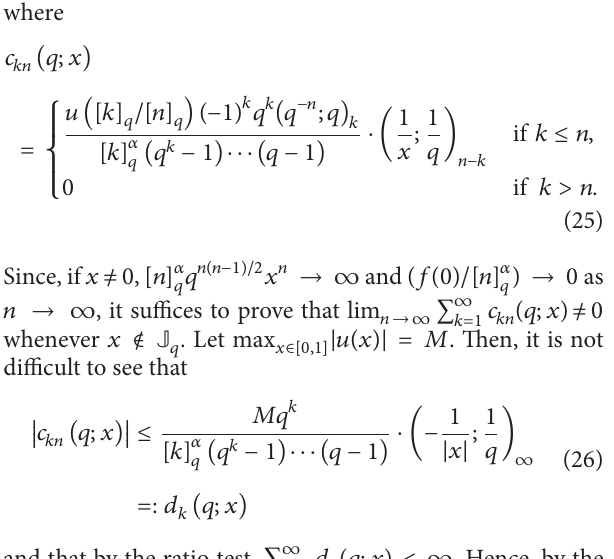
Figure 1: Graphs of 𝑦 = 𝑔(𝑥) and 𝑦 = 𝐵 𝑛,2 (𝑔;𝑥),𝑛 = 4